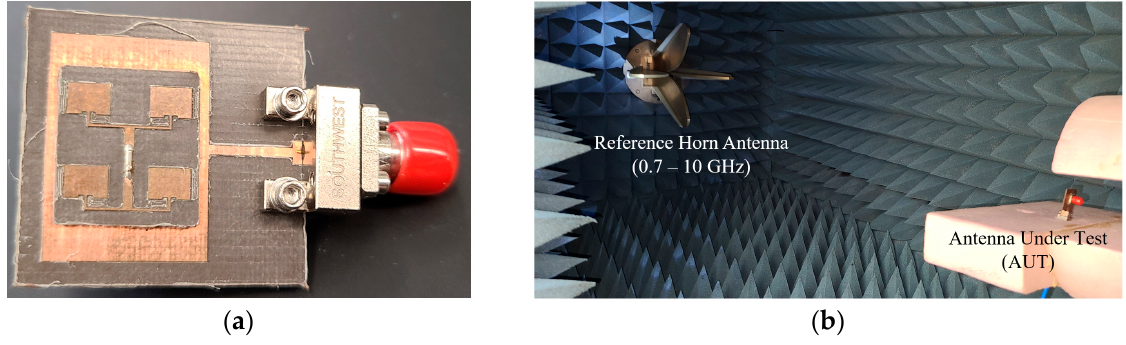
Figure 15. Fabricated dual-band DSRC+5G stacked patch antenna: ( a ) Top view and ( b ) in anechoic chamber.